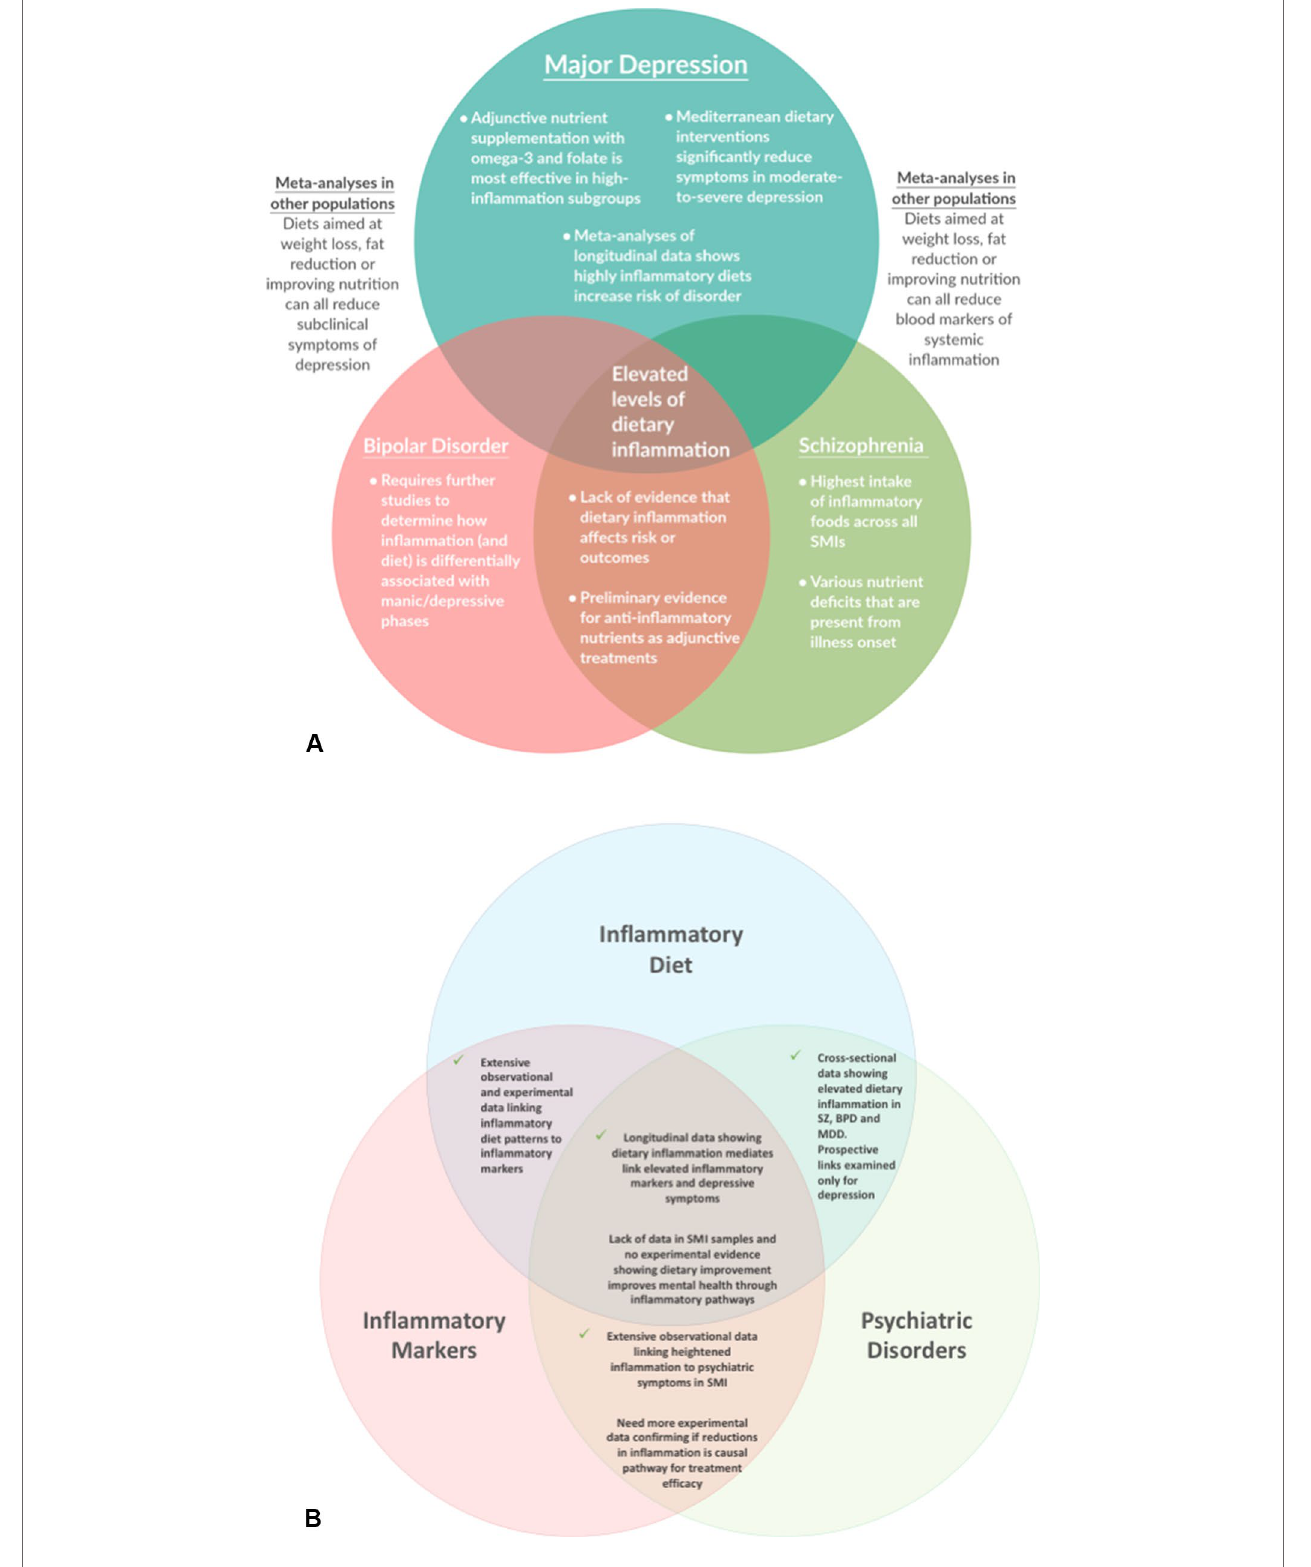
FIGURE 2 | Key Findings and Future Questions: A map of the evidence for the role of dietary inflammation in severe mental illnesses (SMI), with regard to (A) different conditions, and (B) different aspects of the interaction between dietary inflammation, inflammatory markers, and psychiatric